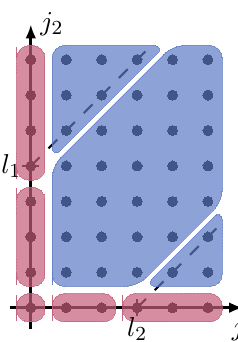
summation variables presented on −